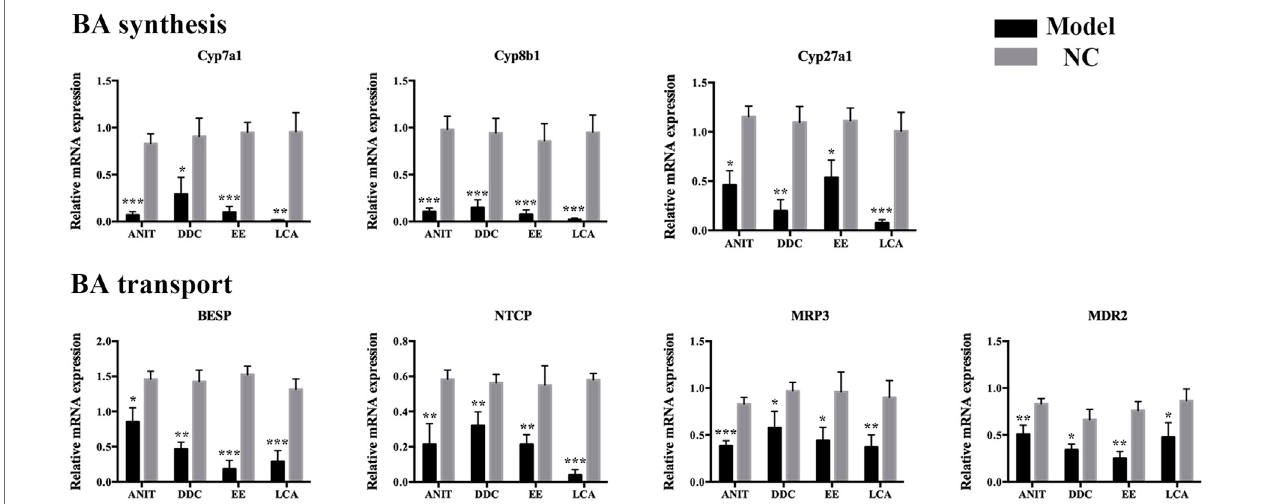
FIGURE 5 | PCA score plots based on the lipid pro fi ling of the four models versus their NC groups. (A) ANIT group vs. ANIT-C group. (B) DDC group vs. DDC-C group. (C) EE group vs. EE-C group. (D) LCA group vs. LCA-C group. (n = 8).